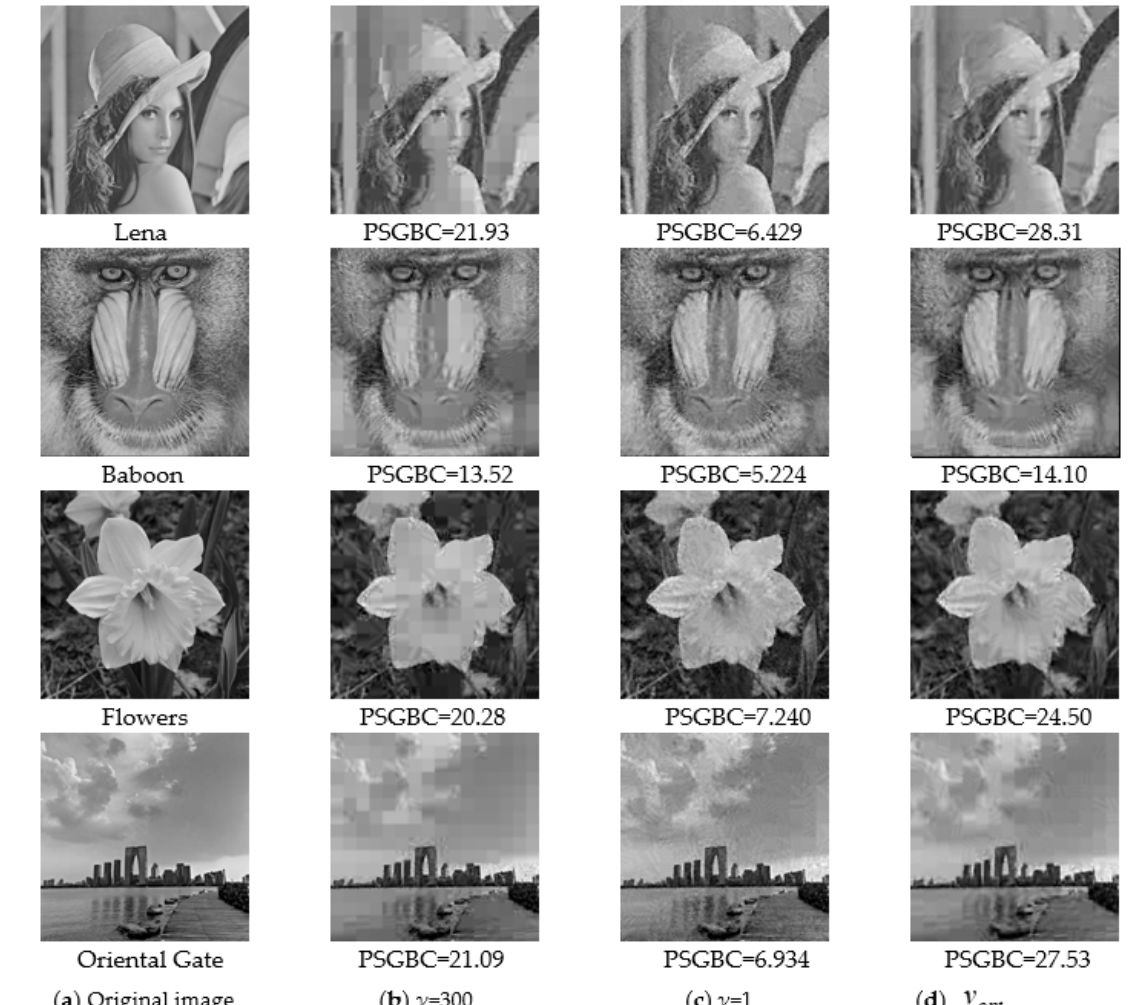
v at the condition of Noise-std = 20 and opt